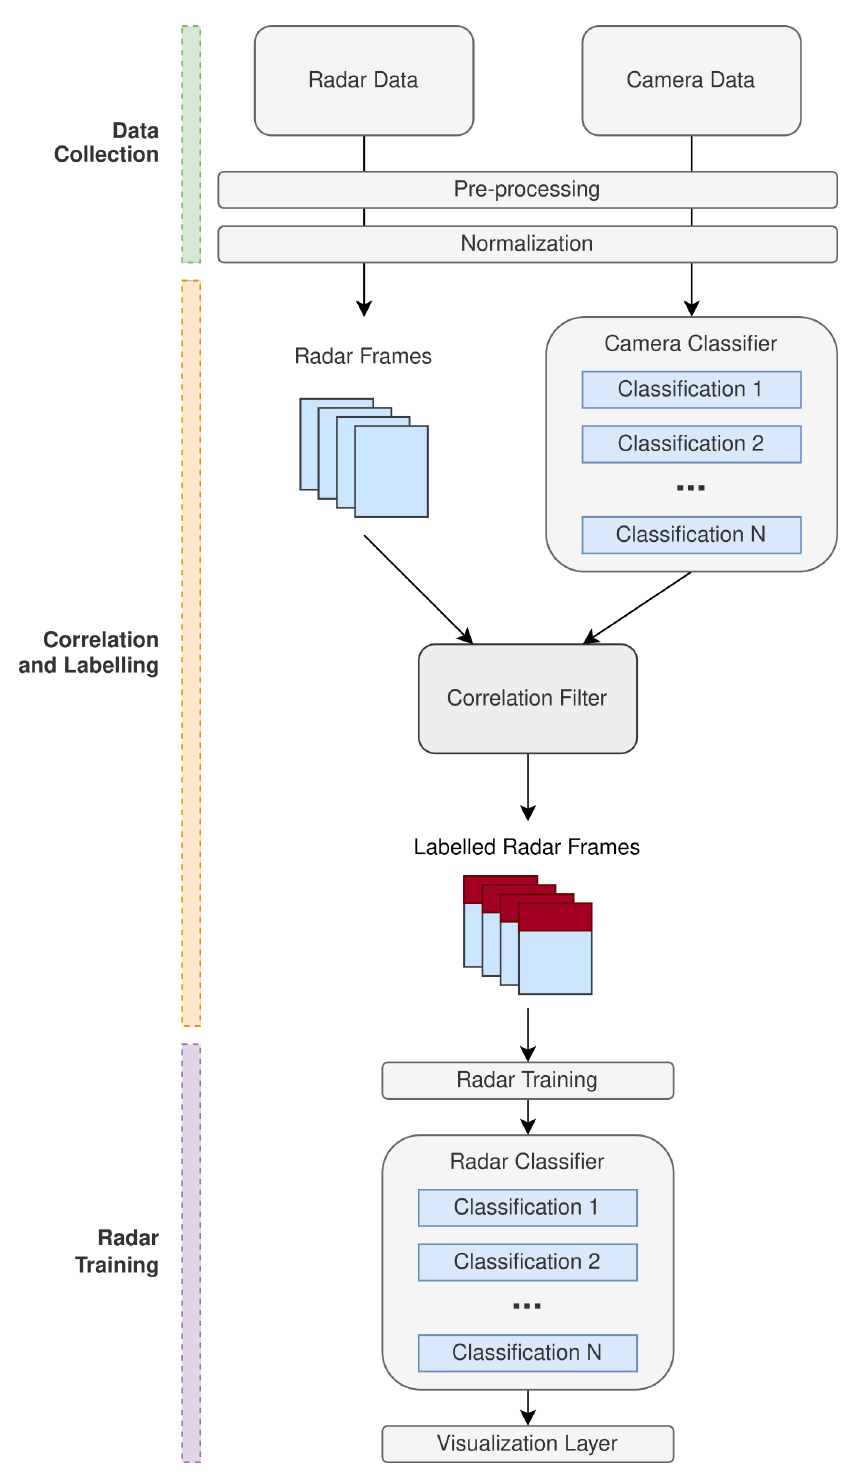
Figure 1. Processing chain for the proposed radar training with camera labeling and supervision